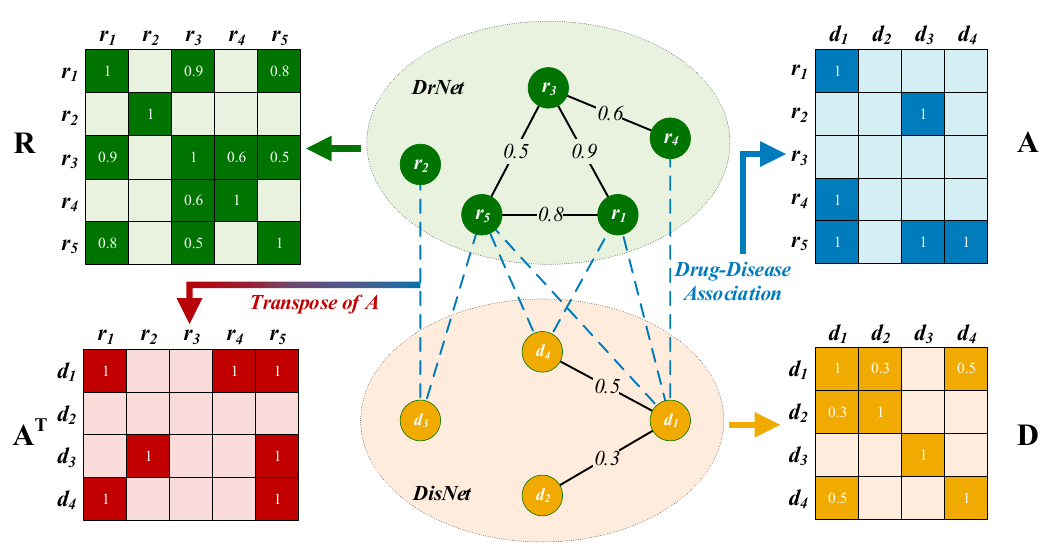
Figure 1. Construction of drug-disease heterogeneous network DrDisNet. R and D are the similarity matrix of drugs and diseases, respectively. A is the association matrix between drugs and diseases, while A T is the transpose of A .